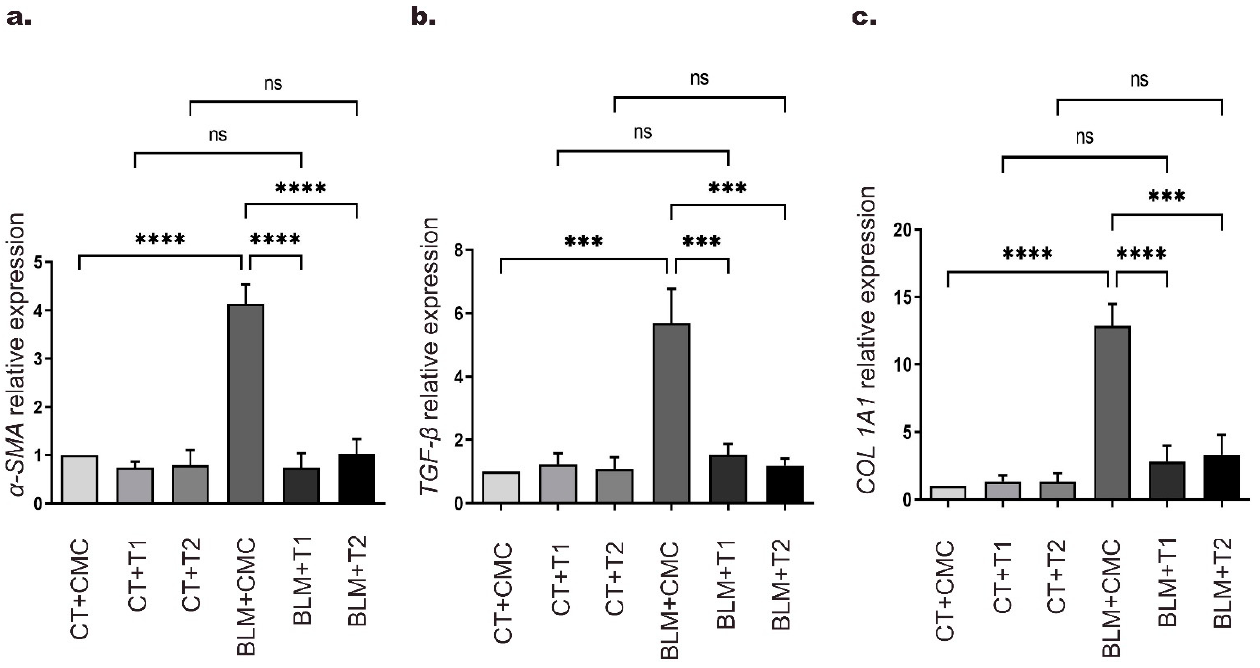
Figure 3. 3 ′ 5-DMBA modulates gene expression related to BLM-induced lung fibrosis in mice. Mice in BLM groups were instilled with an osmotic minipump loaded with BLM 100 U/kg. Mice in control groups (CT) have a sham instillation. On day 14, mice received either 3 ′ 5-DMBA or its vehicle intragastrically until they were euthanized on day 28. The mRNA levels of ( a ) α -SMA ; ( b ) TGF- β 1 , and ( c ) COL1A1 , were determined by real-time quantitative PCR (RT-qPCR) in mouse lung tissue. CT+CMC: control group, BLM+CMC: BLM-treated group, BLM+T1: BLM plus 3 ′ 5-DMBA-treated group at a dose of 6 mg/kg, and BLM+T2: BLM plus 3 ′ 5-DMBA-treated group at a dose of 10 mg/kg. Data are represented as the mean ± SD ( n = 4). Data were analyzed by one-way ANOVA followed by Tukey’s t -test for comparison between groups. For each graph, the asterisks above the horizontal lines indicate significant differences with respect to their control groups and differences between the two doses and the vehicle.*** p < 0.001, and **** p < 0.0001. BLM: bleomycin, CMC: carboxymethylcellulose (vehicle), and 3 ′ 5-DMBA: 3 ′ 5-dimaleamylbenzoic acid.